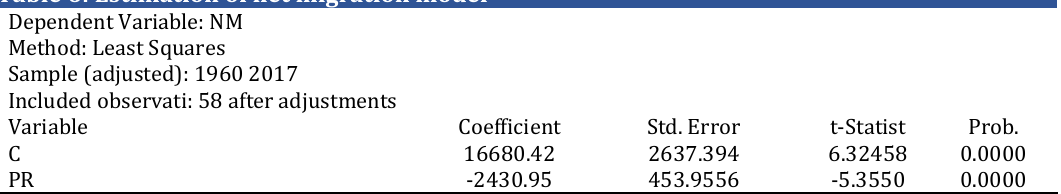
Table 6: Estimation of net migration model